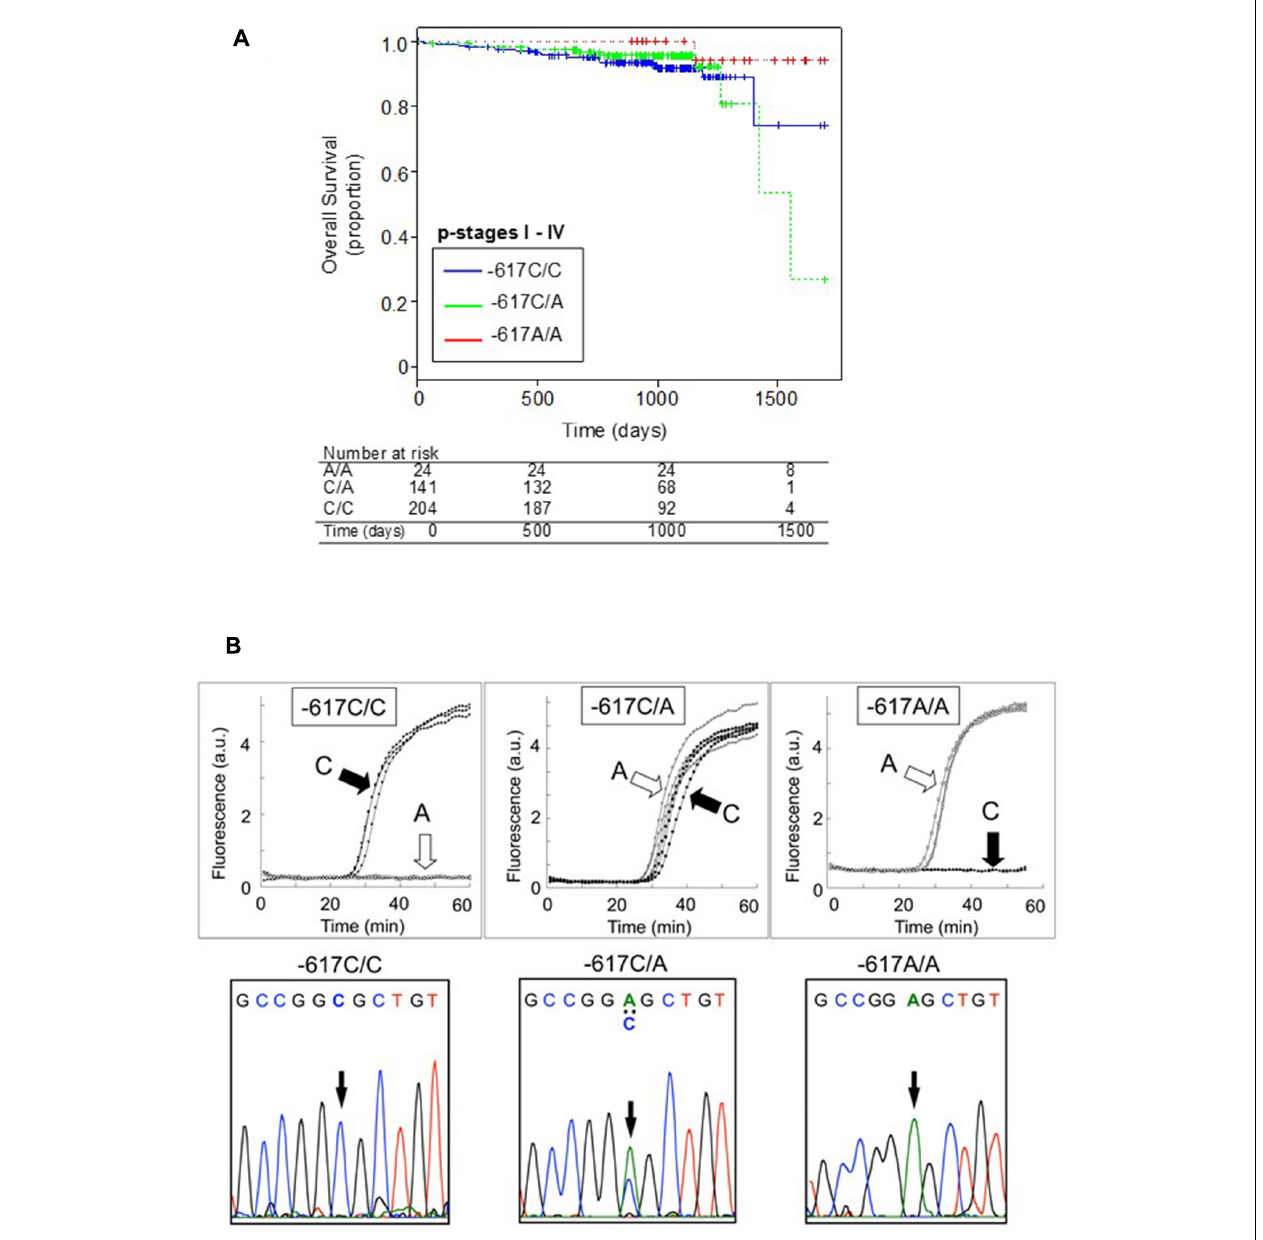
FIGURE 2 | Kaplan-Meier plots showing the overall survival of patients harboring theWT homozygote ( − 617C/C), WT/SNP heterozygote ( − 617C/A), or SNP homozygote ( − 617A/A) in the NRF2 gene (A) and genotyping of NRF2 SNP − 617C > A by the rapid SNP-detection method (B, upper panels) and DNA sequence analysis (B, lower panels). Data from Okano etal.